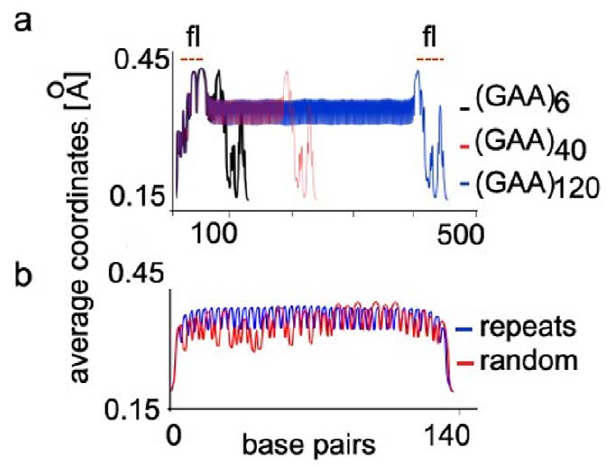
Figure 1. Accumulation of (GAA.TTC) repeats leads to changes in local DNA breathing. BAD criteria are used to describe and compare the local base pair breathing of DNA sequences with different numbers of (GAA.TTC) repeats embedded within the frataxin gene [B7] promoter sequence. a) BAD coordinates [A˚] are calculated with EPBD based MCMC simulations for sequence inserts with different numbers of repeats: (GAA.TTC) 6 -black line, (GAA.TTC) 45 -red line, and (GAA.TTC) 120 - blue line. The position of the flanking sequence (fl) is shown above the panel. b) BAD coordinates for a randomized sequence with the same number of base pairs and G + C content as the (GAA.TTC) 41 sequence. The random sequence (red line) is missing the synchronized average base pair openings behavior of the symmetric (GAA.TTC) 41 (blue line). The nucleotide position is shown on the horizontal. The BAD coordinates are shown on the vertical in